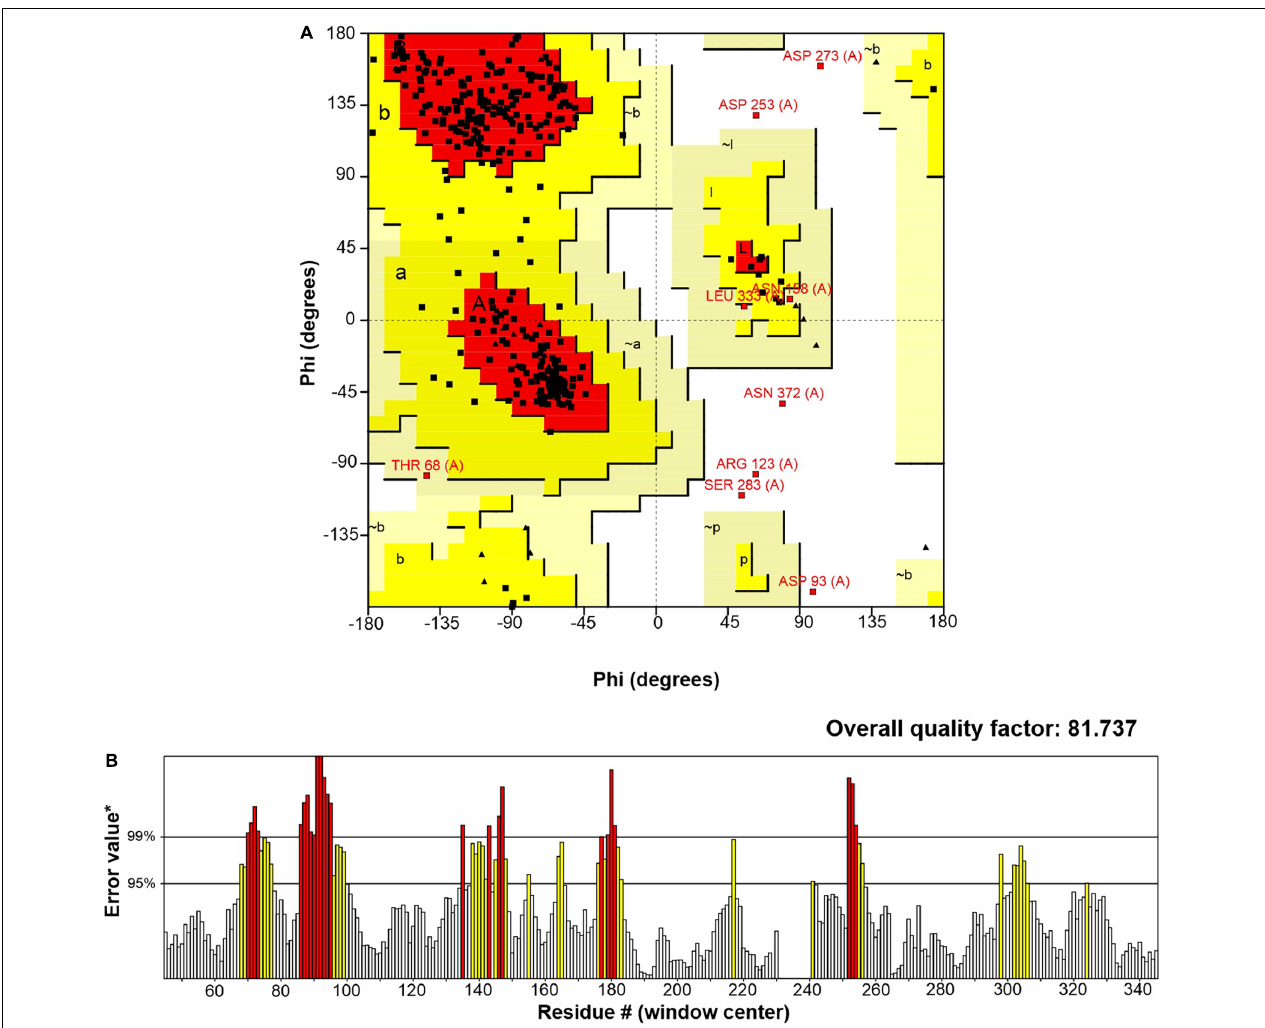
FIGURE 3 | Structural model of the xylanase-ferulic acid esterase R13 Fae of Rahnella sp. ChDrAdgB13: (A) Ramachandran plot, residues in the most favored regions (A, B, L), residues in additional allowed regions (a, b, l, p), residues in generously allowed regions ( ∼ a, ∼ b, ∼ l, ∼ p), residues in disallowed regions (white region). (B) Errat plot and error-values*, based on the statistics of non-bonded atom-atom interactions in the